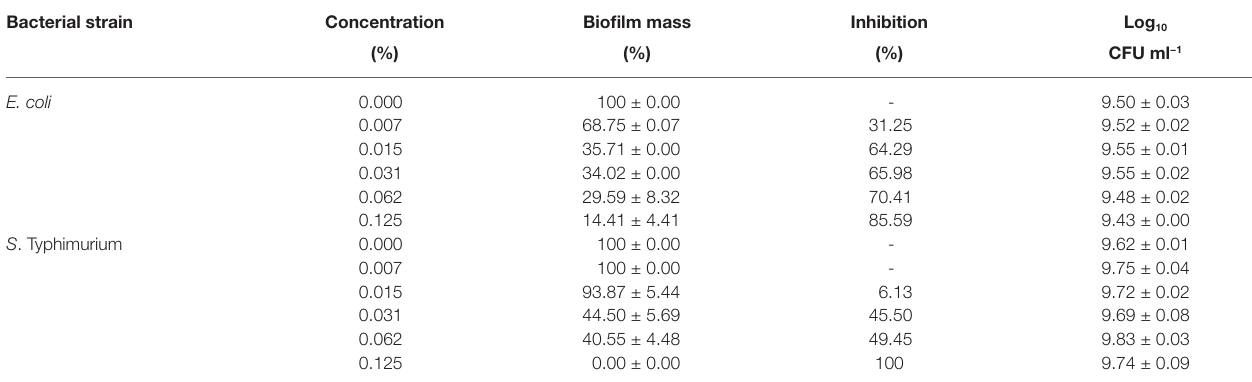
TABLE 2 | Inhibition of biofilm formation by Escherichia coli O157:H7 and Salmonella Typhimurium JSG 1748 using GCEO. Bacterial strain Concentration